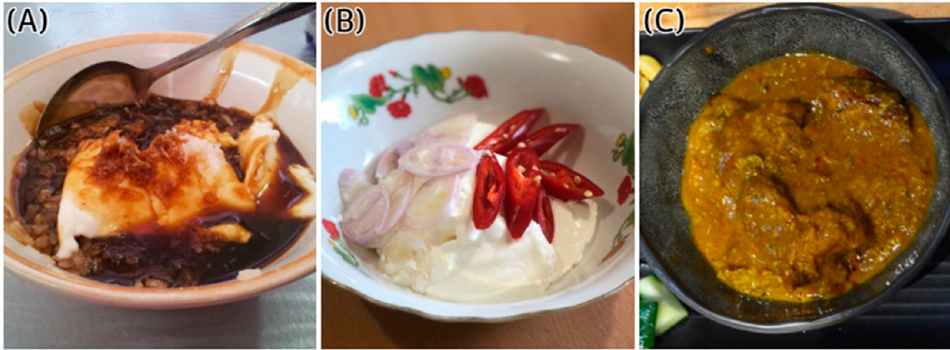
Figure 3. Dadih —fermented buffalo milk in various dishes. ( A ) Ampiang dadih ( ampiang dadiah ). Traditional food of Minangkabau, consists of dadih , ampiang (glutinous rice flakes), shaved ice, shredded coconut or coconut milk, and palm sugar syrup as the topping. Photo by: Dinda (CC BY-NC 2.0, source: https://www.flickr.com/photos/41912023@N07/8908205779). ( B ) Dadih —fermented buffalo milk served with sliced shallot and chili. Authors hold the copyright. ( C ) Beef curry (rendang). Dadih —fermented buffalo milk can be used as the substitute of coconut milk in beef curry. Photo by: Alpha (CC BY-NC 2.0, source: https://www.flickr.com/photos/avlxyz/39545761832/in/ photostream/) (accessed on 29 May